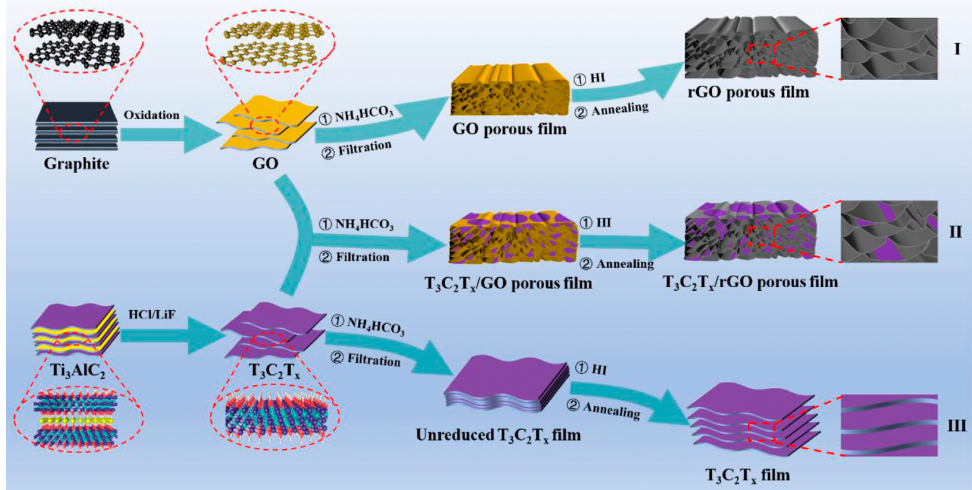
Figure 14. Schematic illustration of the fabrication of the Ti 3 C 2 T x /rGO porous film; reproduced from [57], with the permission of Elsevier.